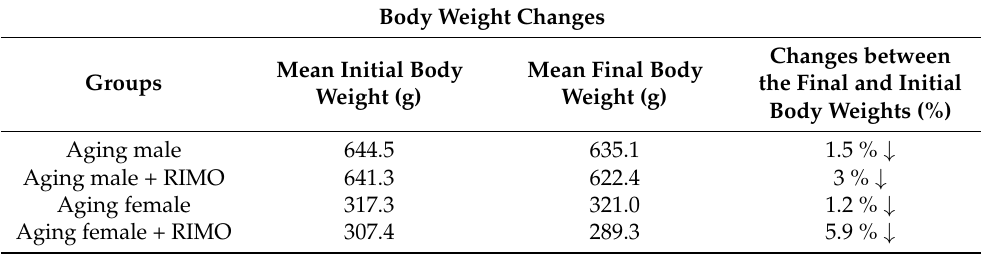
Table 7. Mean body weight values of male and female rimonabant-treated and untreated groups, and body weight changes measured between the initial and final days of the experimental period. RIMO = rimonabant. ↓ : decrease of the